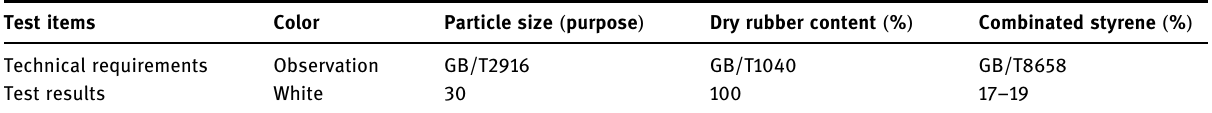
Table 4: Technical indicators of